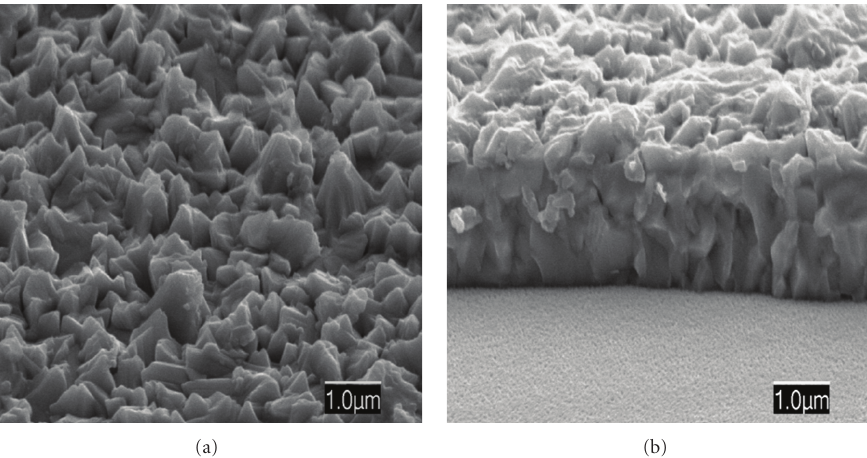
Figure 1: Surface (a) and cross-sectional (b) scanning electron microscopy (SEM) images of Cu(In,Ga)Se 2 films deposited by a hybrid